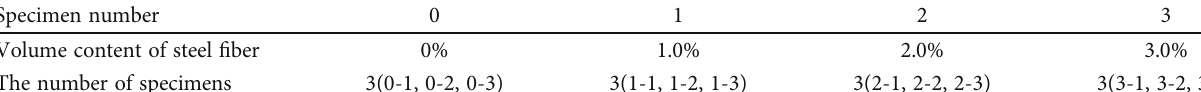
Table 1: Serial number of specimens.